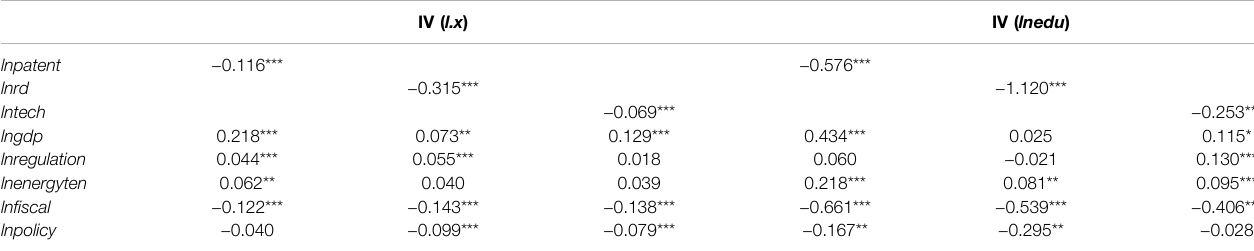
TABLE 5 | Instrumental variable regression results.